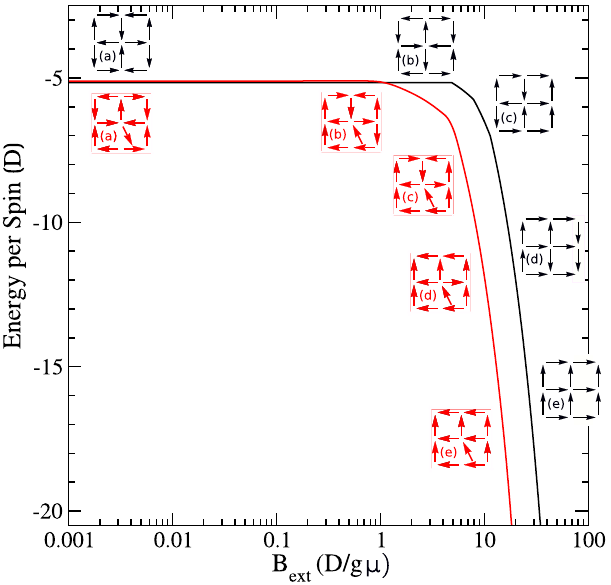
Figure 3. Most probable, minimum energy magnetic configurations for the undeformed (black) and deformed (red) windows plotted against external field. Magnetic field is applied at an angle of 10 ◦ with respect to the easy axis of the vertical nanoislands for the former and 7 ◦ for the latter sample. Configurations a and b are the possible ground states for both samples. For undeformed samples, as the external field increases to near 5 D / g µ , configuration b still shows the most probable state. With further increase of field, configurations c , d (with a central monopole-like charge excitation) and e (type-II) are observed. The same behavior is observed for the deformed window